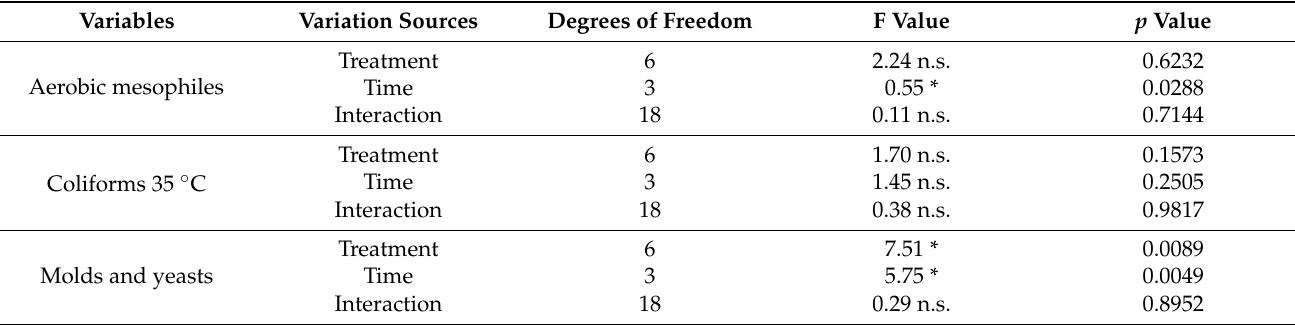
Table 3. Summary of analysis of variance (ANOVA) of the count of aerobic mesophiles, molds and yeasts and coliforms at 35 ◦ C in strawberries during storage of 9 days at 6 ± 1 ◦ C.